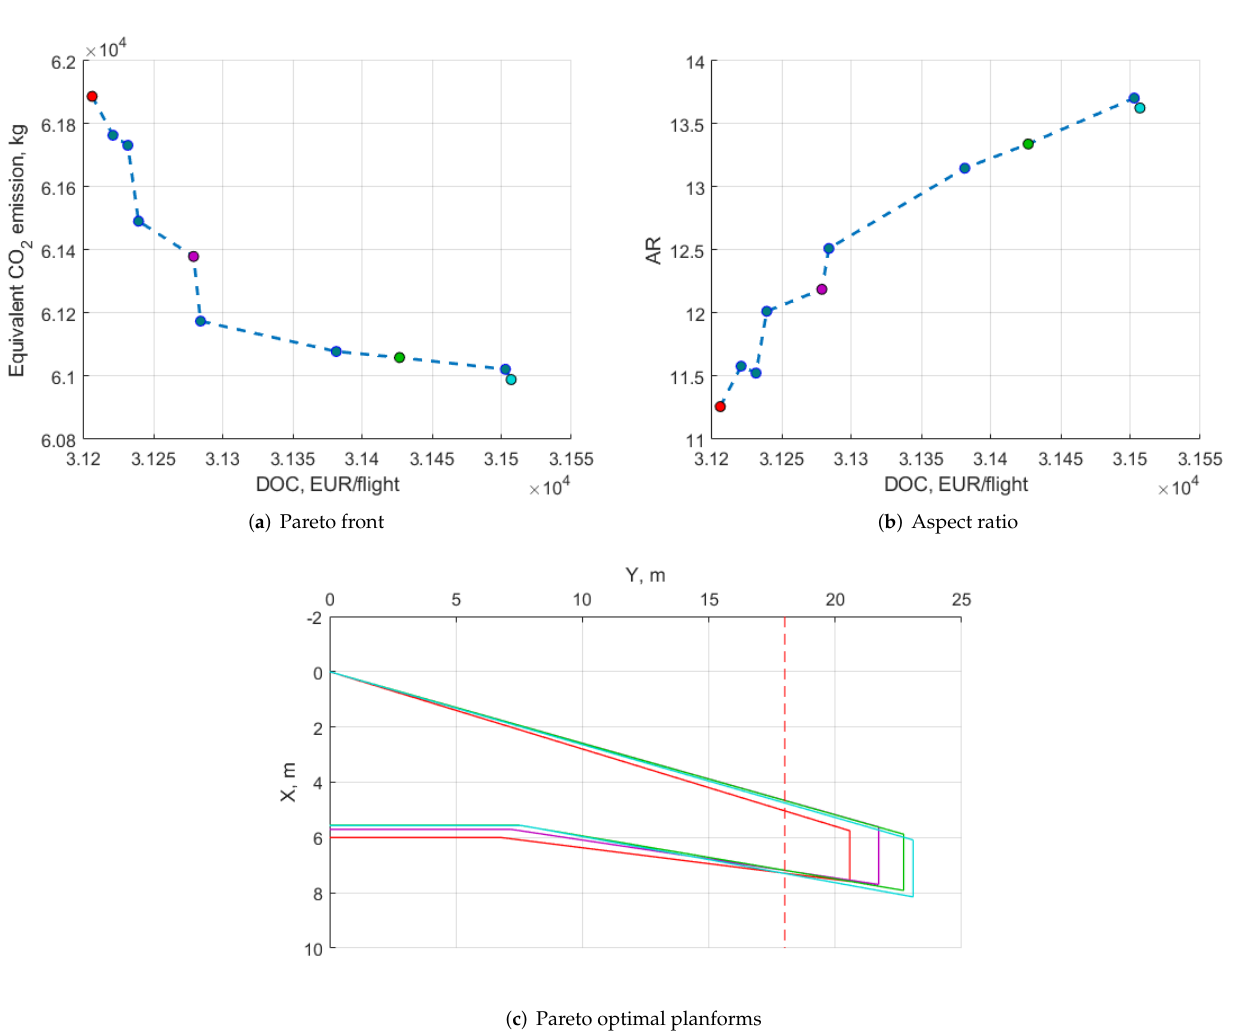
Figure A4. Optimization results for the backward-swept LFC aircraft with a folding wing.